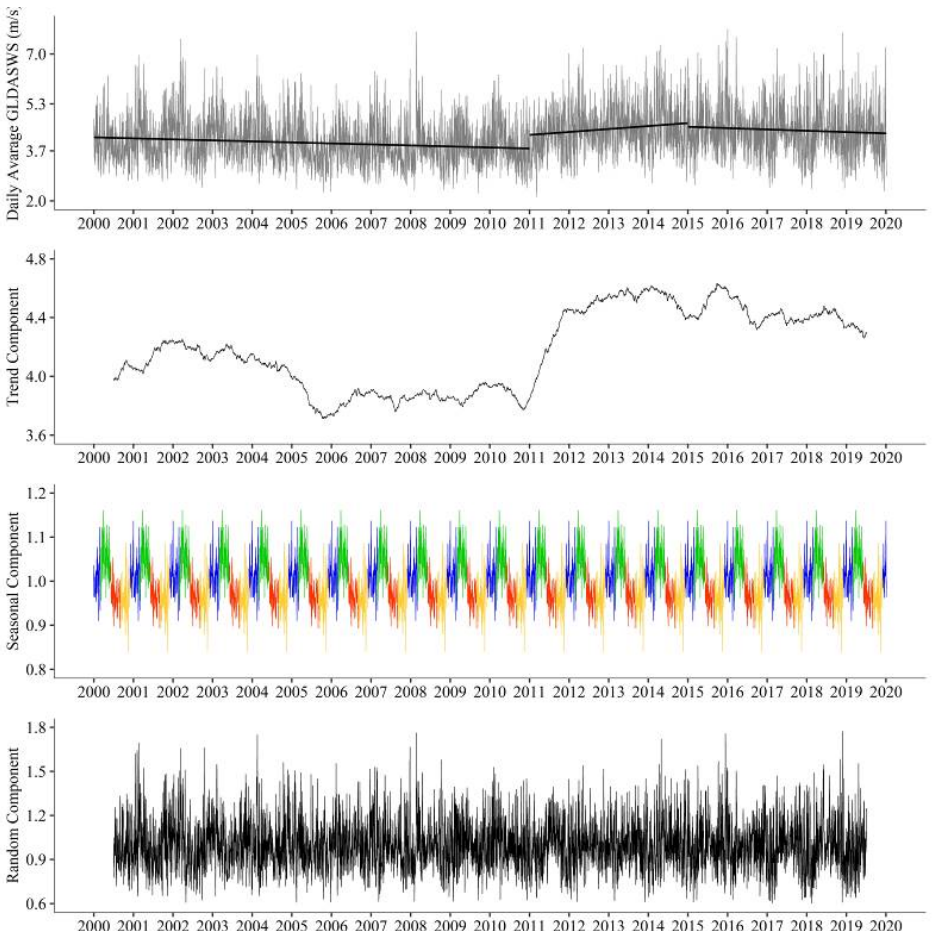
Figure 4. The time series decomposition of the average Global Land Data Assimilation System wind speed (GLDASWS) in CA from 2000 to 2019. Note: The different colors in the graph on the seasonal component indicate different seasons (blue: Winter (Dec., Jan., Feb.), green: Spring (Mar., Apr., May), red: Summer (Jun., Jul., Aug.), and yellow: Autumn (Sept., Oct., Nov.)).